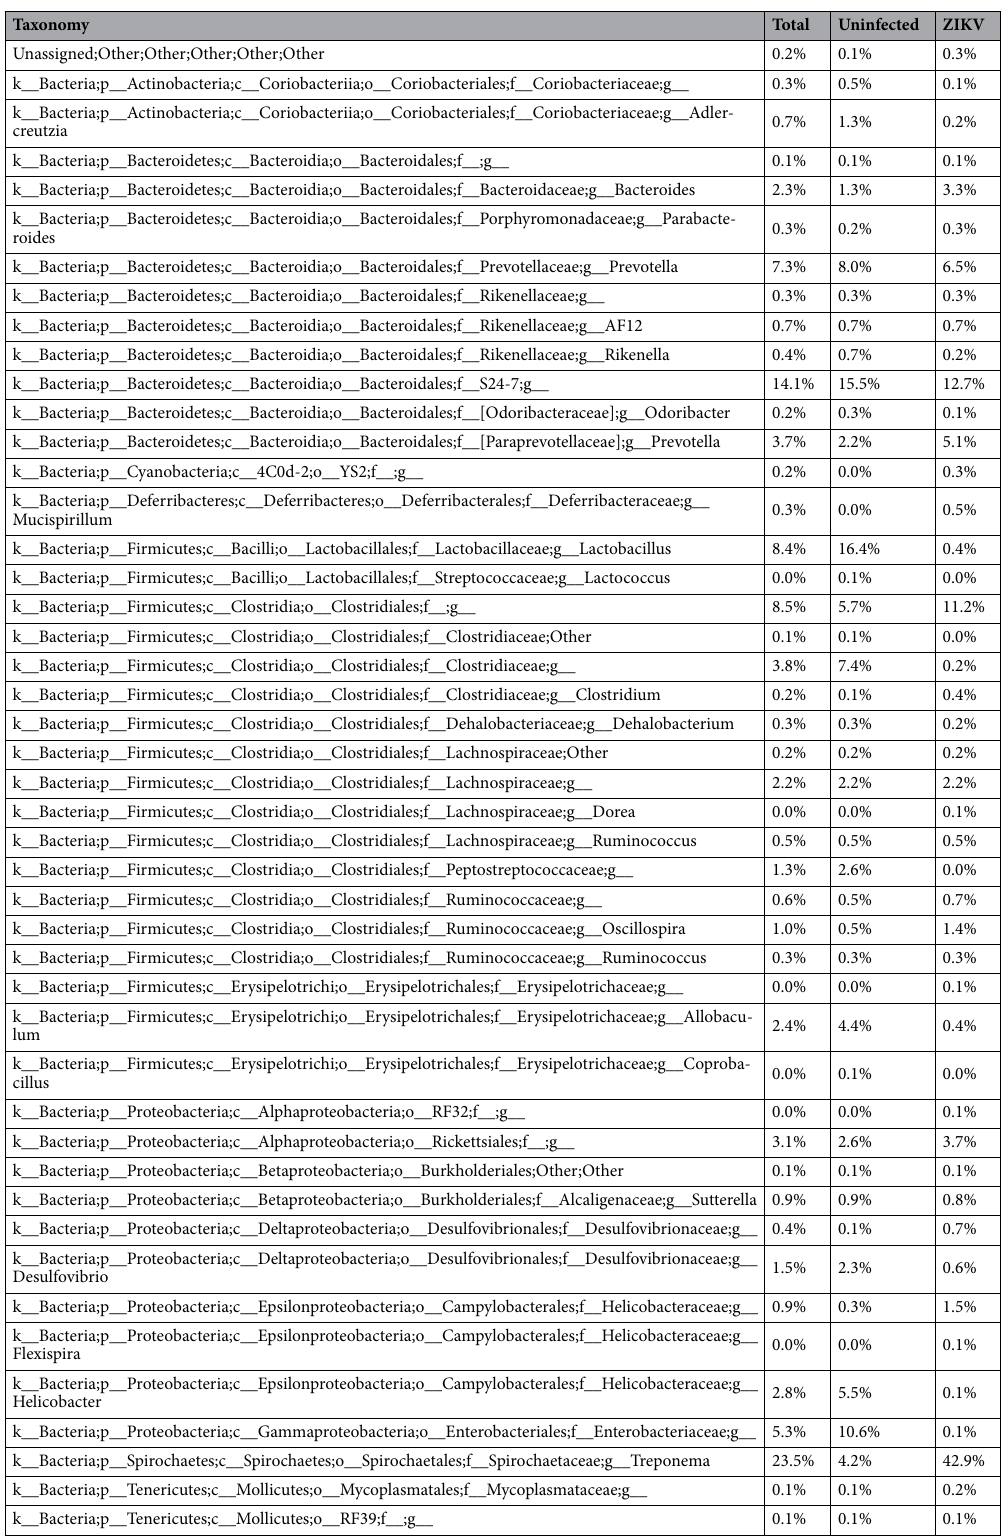
Table 2. Modulation of the bacterial genera abundance triggered by ZIKV infection in the adult immunocompetent